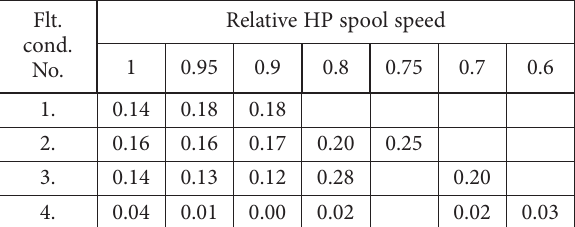
Table 4. Relative change of the fan speed d_ n 1 (absolute value),